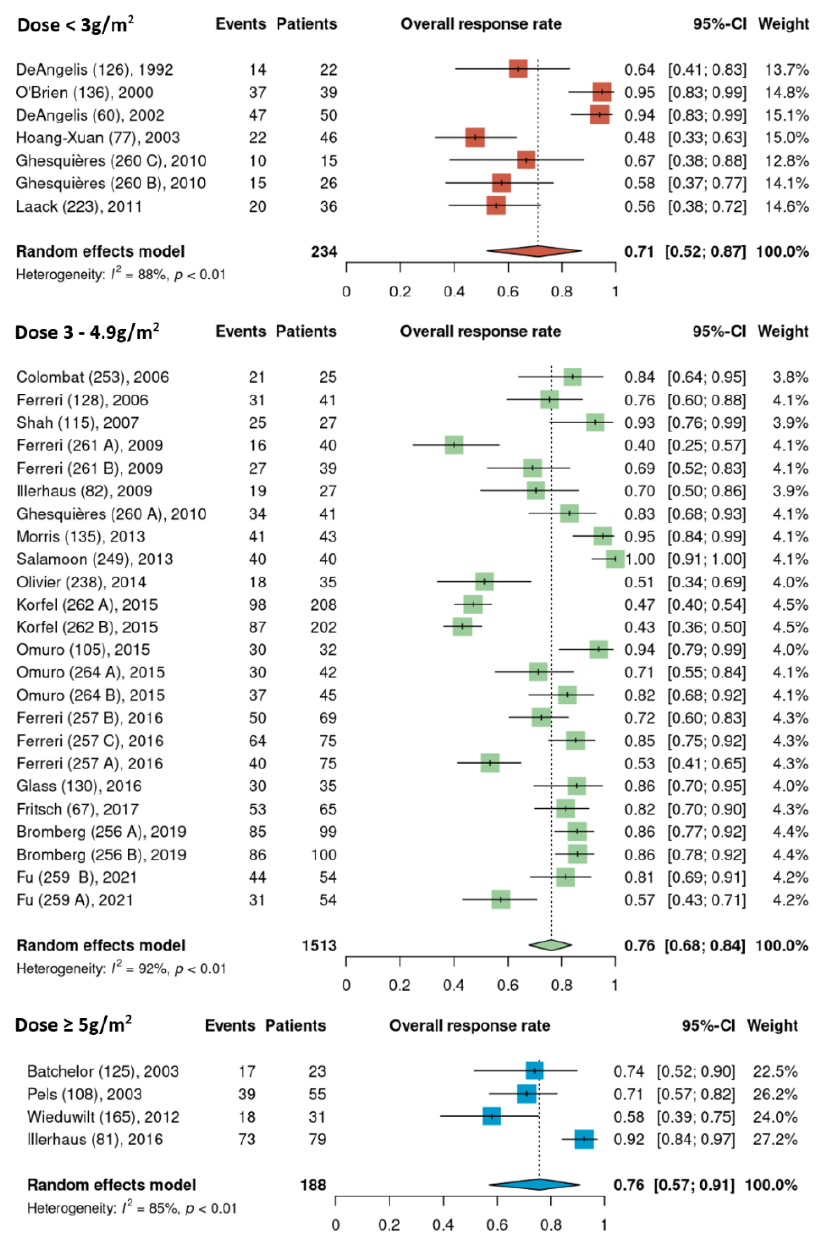
Figure 2. Overall response rates of the different HDMTX dose categories [12,14,15,18,21 – 42].